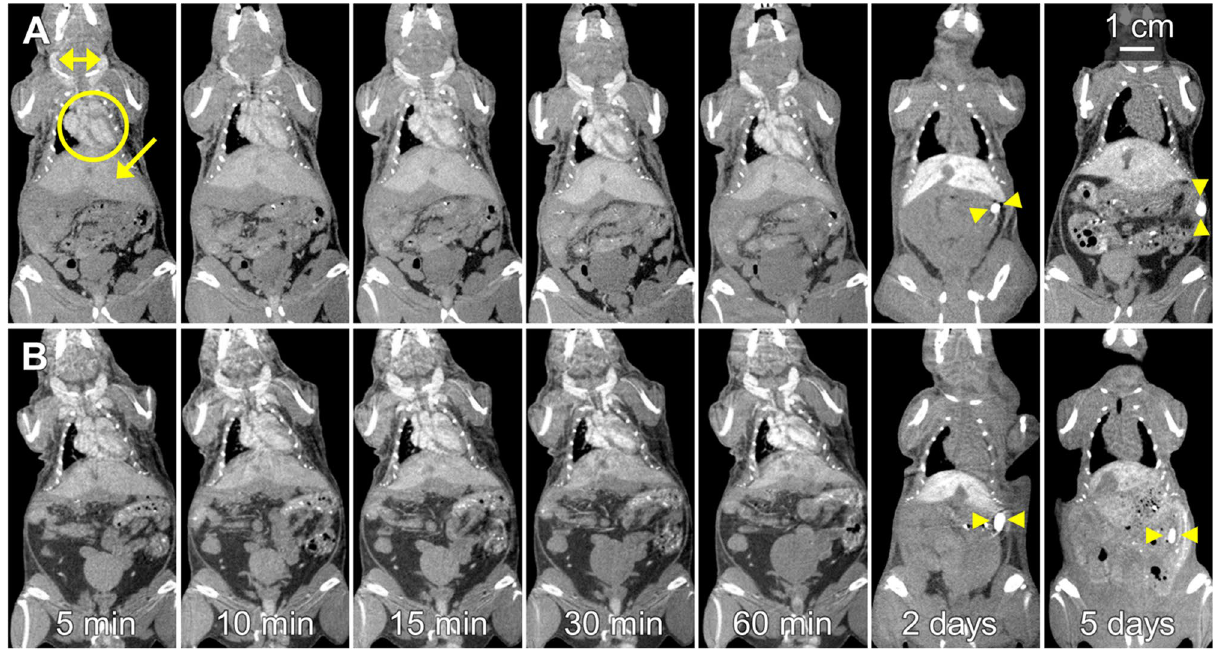
Figure 4. Representative coronal micro-CT images showing the heart, liver, jugular veins, and spleen of mice that received contrast agent formulated with ( A ) PPEG 2000 -GdNP and ( B ) PPEG 5000 -PPEG 1000 -GdNP. All times were reported from the completion of the contrast agent injection. In the 5-min image in ( A ), the blood in the chambers of the heart (circle), liver (arrow) and the external jugular veins (double arrowheads) are clearly visible. In the 2- and 5-day images, the blood pool in the heart is no longer visible, the liver remains visible, and the spleen (arrowheads) becomes visible. Adjacent anatomical slices were shown for the images acquired within 60 min, while slices located 1 cm posterior were shown in the 2- and 5-day images, to demonstrate the high contrast in the previously indistinguishable spleen.